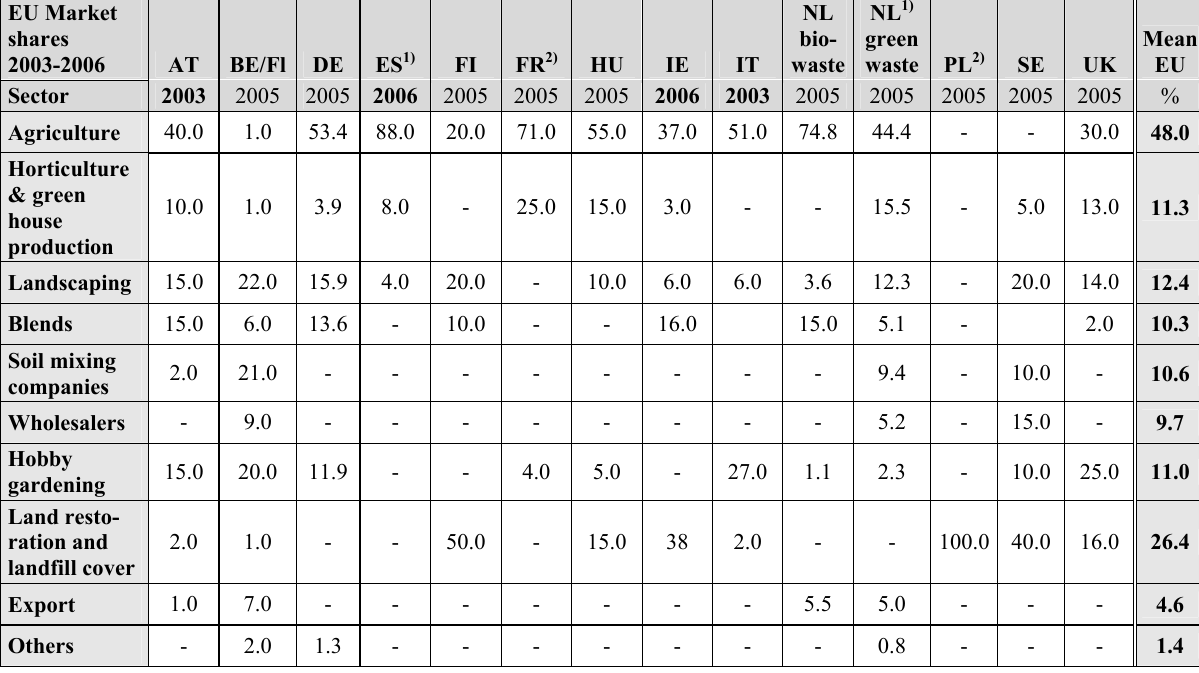
Table 34: Compost market shares of various sectors in major European